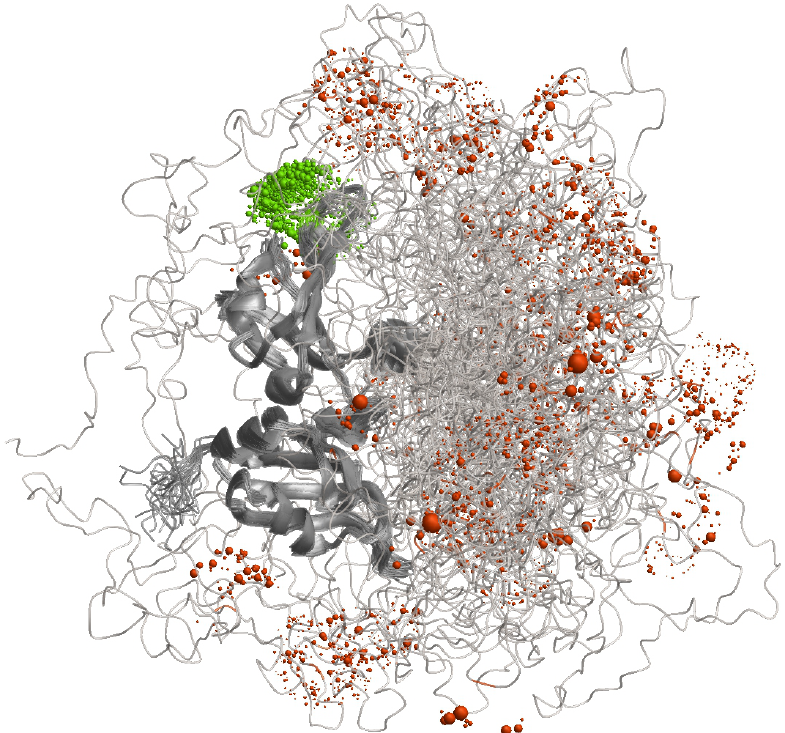
Figure 4. Characterisation of conformer distribution by labelling approaches. Shown is an ensemble model for the RNA-binding protein hnRNP A1 in its free, dispersed form (model determined with DEER and SAXS restraints from [21]). The ensemble was reduced to 46 conformers for clarity of display. Conformers are superimposed on the two RNA-binding domains (residues 1–186). The glycine-rich N-terminal domain (residues 187–320) is largely, but not completely disordered. A spin label at site 144 in the ordered domain (green) is narrowly distributed in space. A spin label at site 252 in the disordered domain (orangered) is broadly distributed in space. Computation of spin label positions by a rotamer library and visualization were performed by